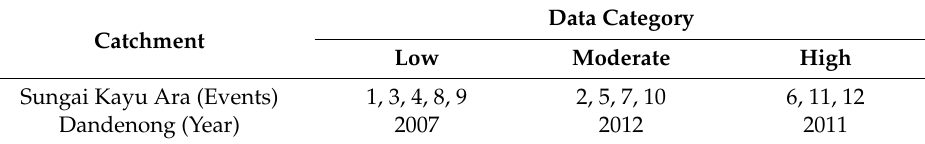
Table 6. Training data categories of low, moderate, and high for the Sungai Kayu Ara and